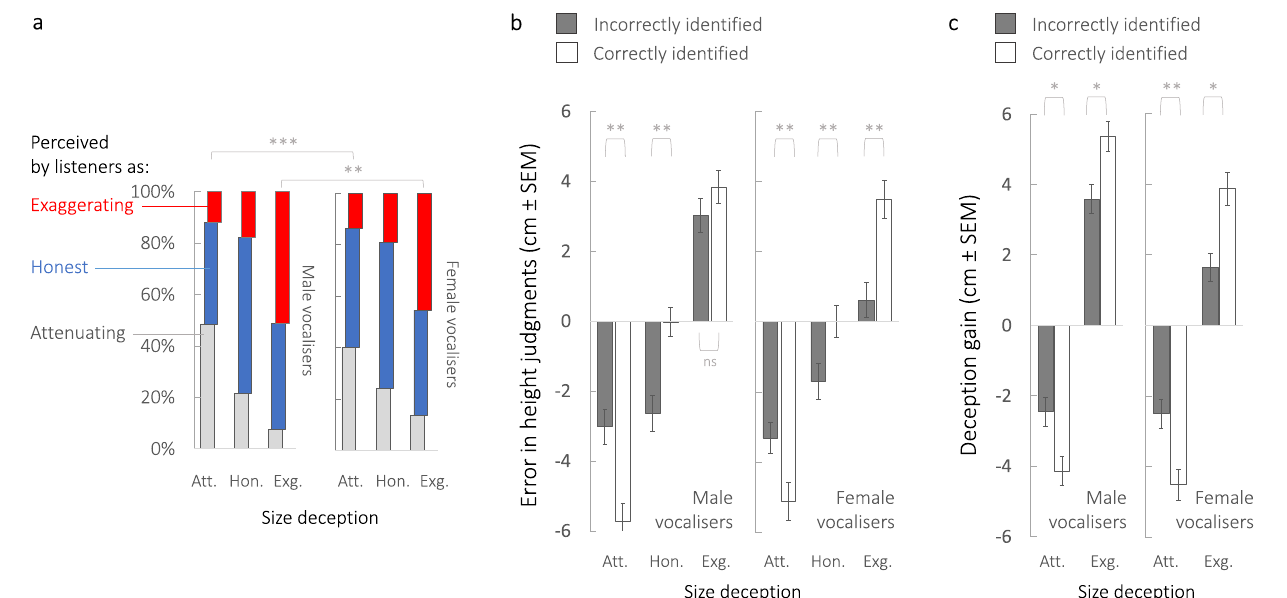
Fig. 3 Listeners can detect deception, but remain deceived by deceptive signals (Experiment 1). a Percentages of vocalisers that listeners perceived as deceptively exaggerating (red bars) or attenuating (light grey bars) their size, or as producing honest vocal signals (blue bars, centre) are shown along the y -axis as a function of the intended size deception indicated along the x -axis. Estimated marginal means and pairwise comparisons derive from LMMs (see Supplementary Table 7), where *** p < 0.001, ** p < 0.01, following Š idák correction for multiple comparisons. Tests are two-tailed. b , c Bias in listeners ’ size assessments as a function of whether a listener failed to detect (dark grey bars) or correctly detected (white bars) a vocal signal as deceptive or honest, where panel b shows ‘ error ’ in height judgements (mean difference between perceived vs actual heights of vocalisers), and panel c shows ‘ deception gain ’ in height judgements (mean difference between perceived height from honest signals and perceived height from deceptive signals). Estimated marginal means and pairwise comparisons derive from LMMs (see Supplementary Tables 8 and 9), ** p < 0.01, * p < 0.05 following Š idák correction. Tests are two-tailed. Error bars ± SEM. Acronyms: Att. attenuating, Hon. honest, Exg. exaggerating. All data derive from Experiment 1, based on 120 vocal stimuli produced by n = 40 vocalisers (20 males, 20 females) in each of three size conditions (honest, attenuating, exaggerating) and judged by n = 97 listeners, where each vocal stimulus was rated by an average of 50 listeners (see Methods). See also Supplementary Fig. 2 for dot plots illustrating distribution of data. Source data are provided as a Source Data fi